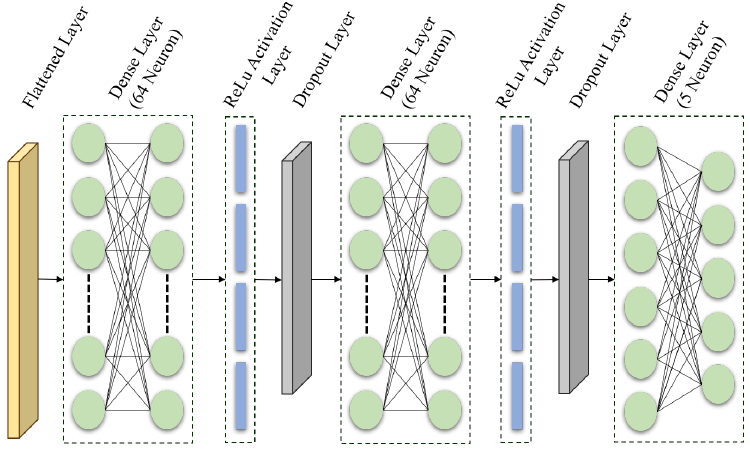
Figure 3. Schematic diagram of proposed